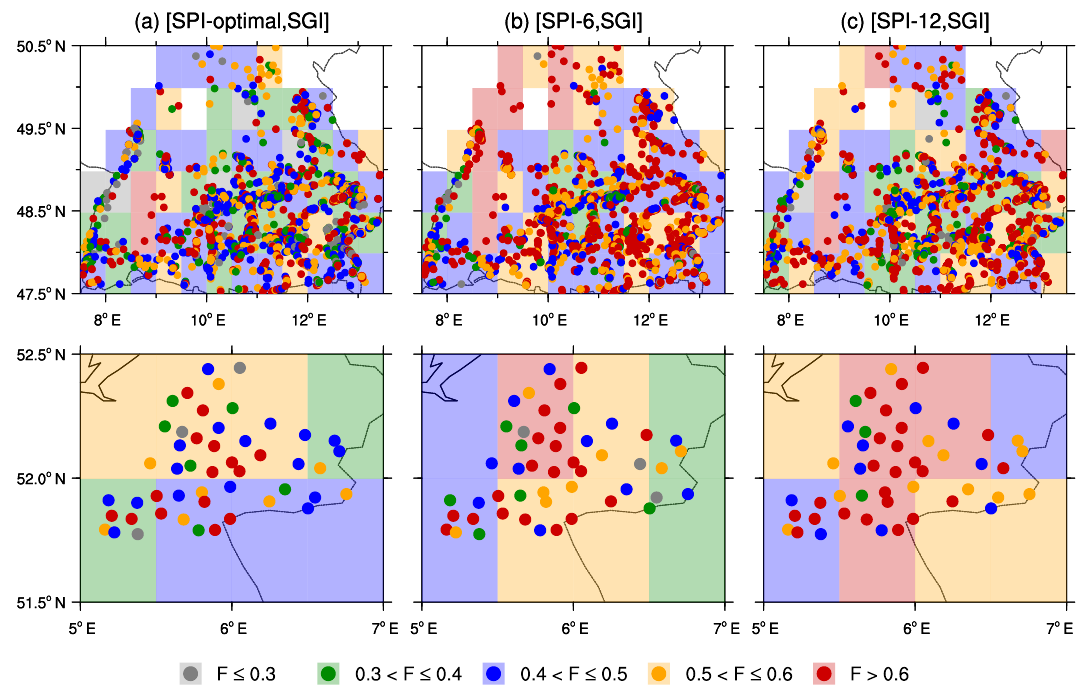
Figure 7. The false alarm ratio ( F ) to detect SGI-based groundwater droughts using the SPI with the (a) optimal accumulation period and (b, c) 6 and 12 months of uniform accumulation periods at the point and gridded scales for German (top) and Dutch (bottom) data sets. A threshold value τ of 0.2 is used to identify drought